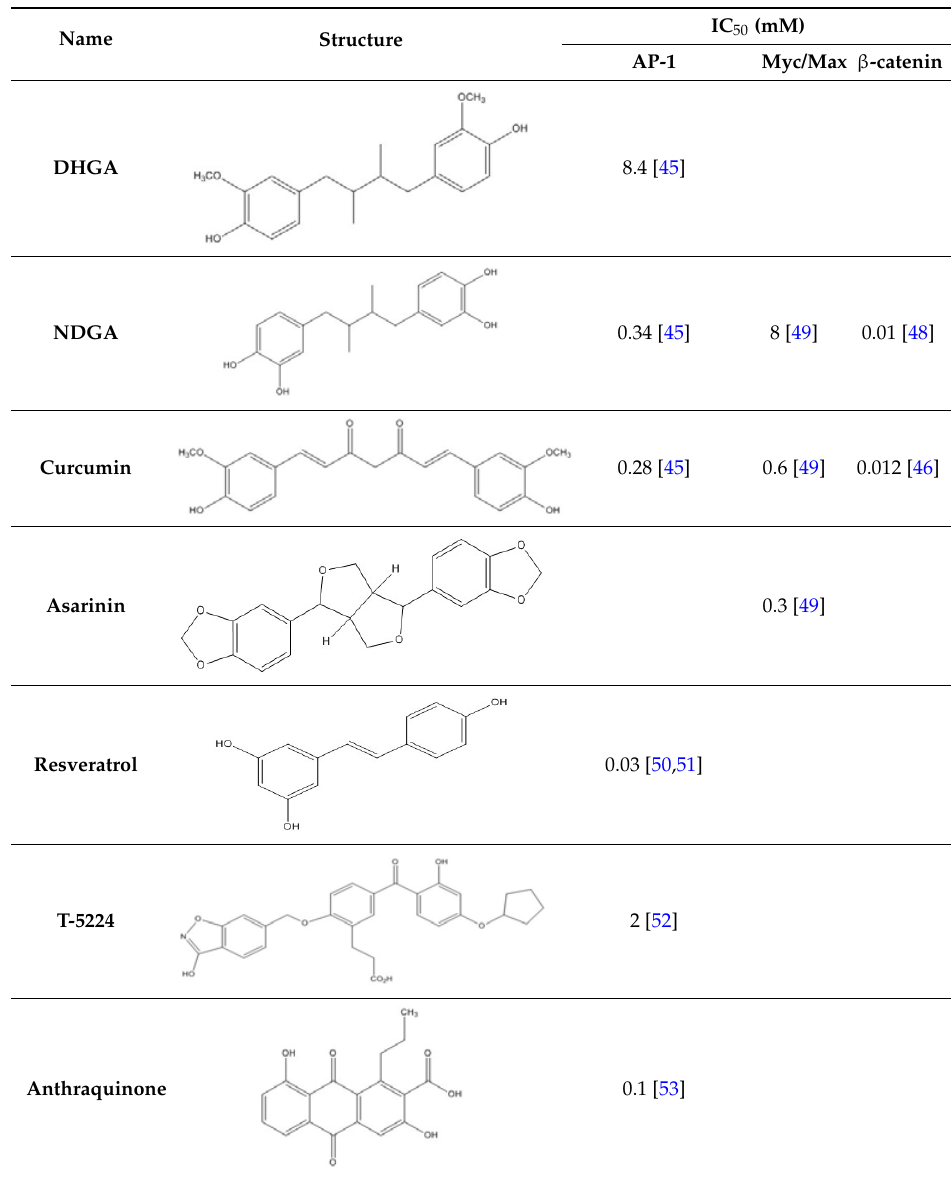
Table 1. Structures and activities of polyphenol inhibitors against c-jun/c-fos (AP-1).